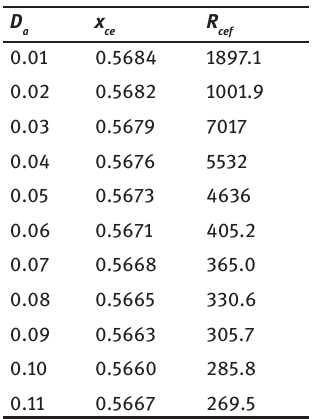
Table 2: The variation in the fluid-based critical thermal Rayleigh number R with the couple-stress parameter ( D cef S = 100. f